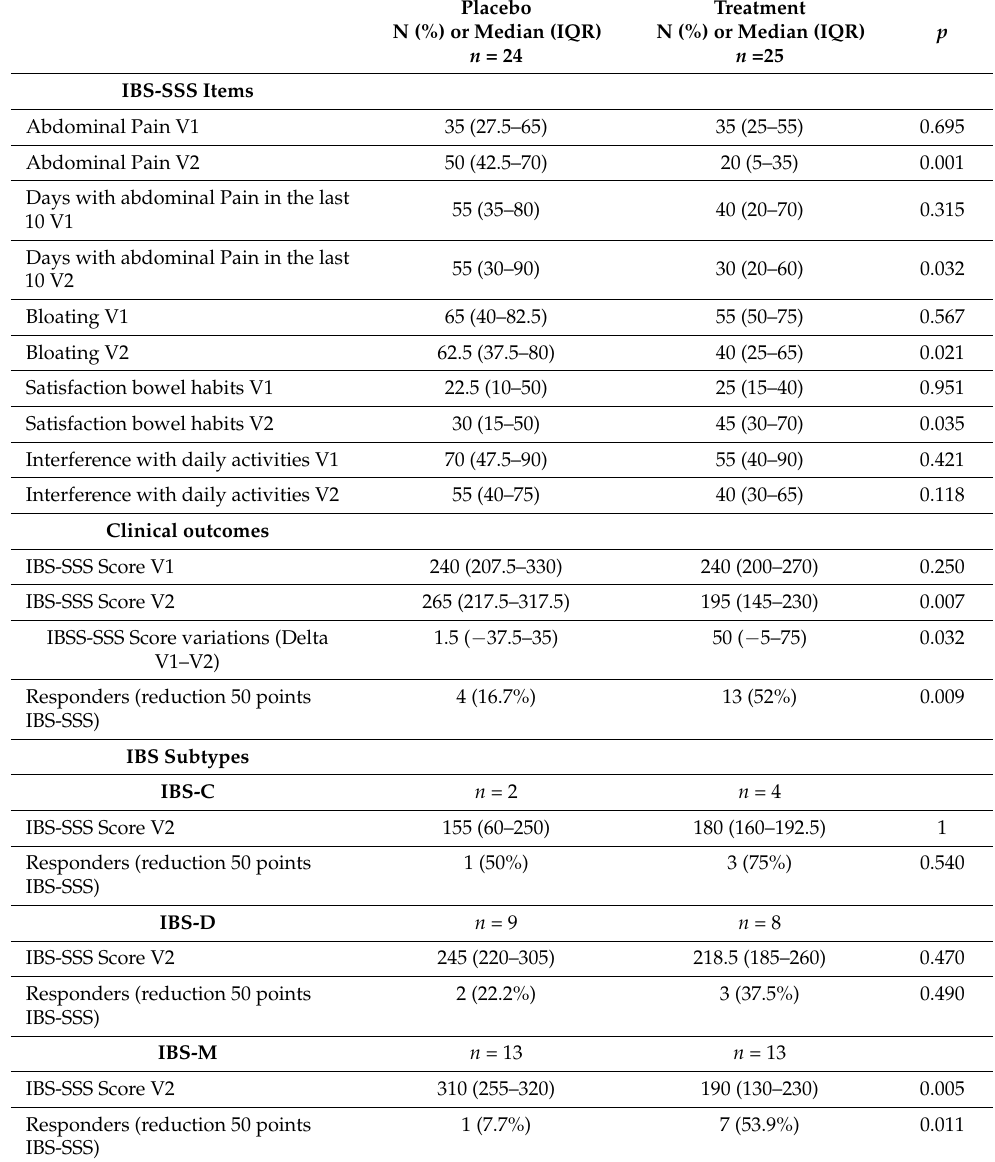
Table 3. IBS-SSS items, clinical outcomes in study cohort and in IBS subtype in placebo and treatment arms (V1 = baseline, V2 = follow-up after 4 weeks from the start of